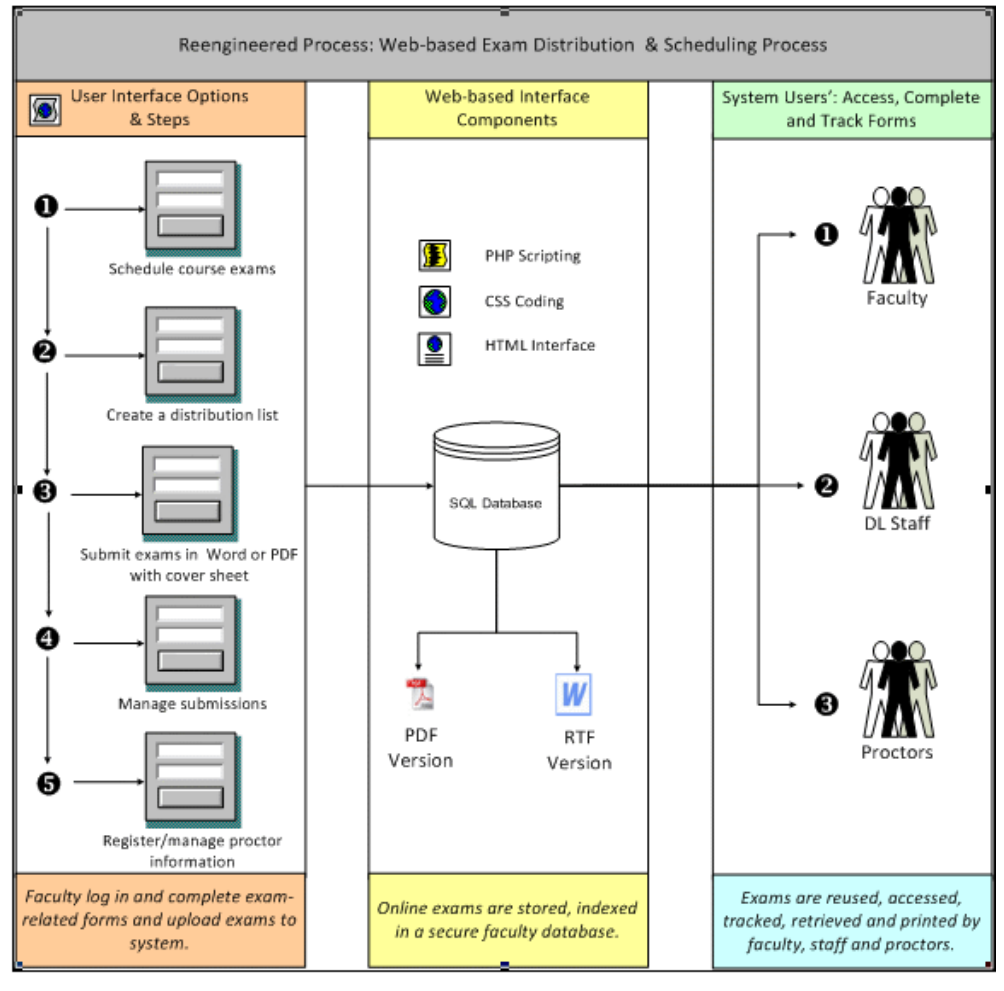
Figure 3. Web-based exam distribution and scheduling